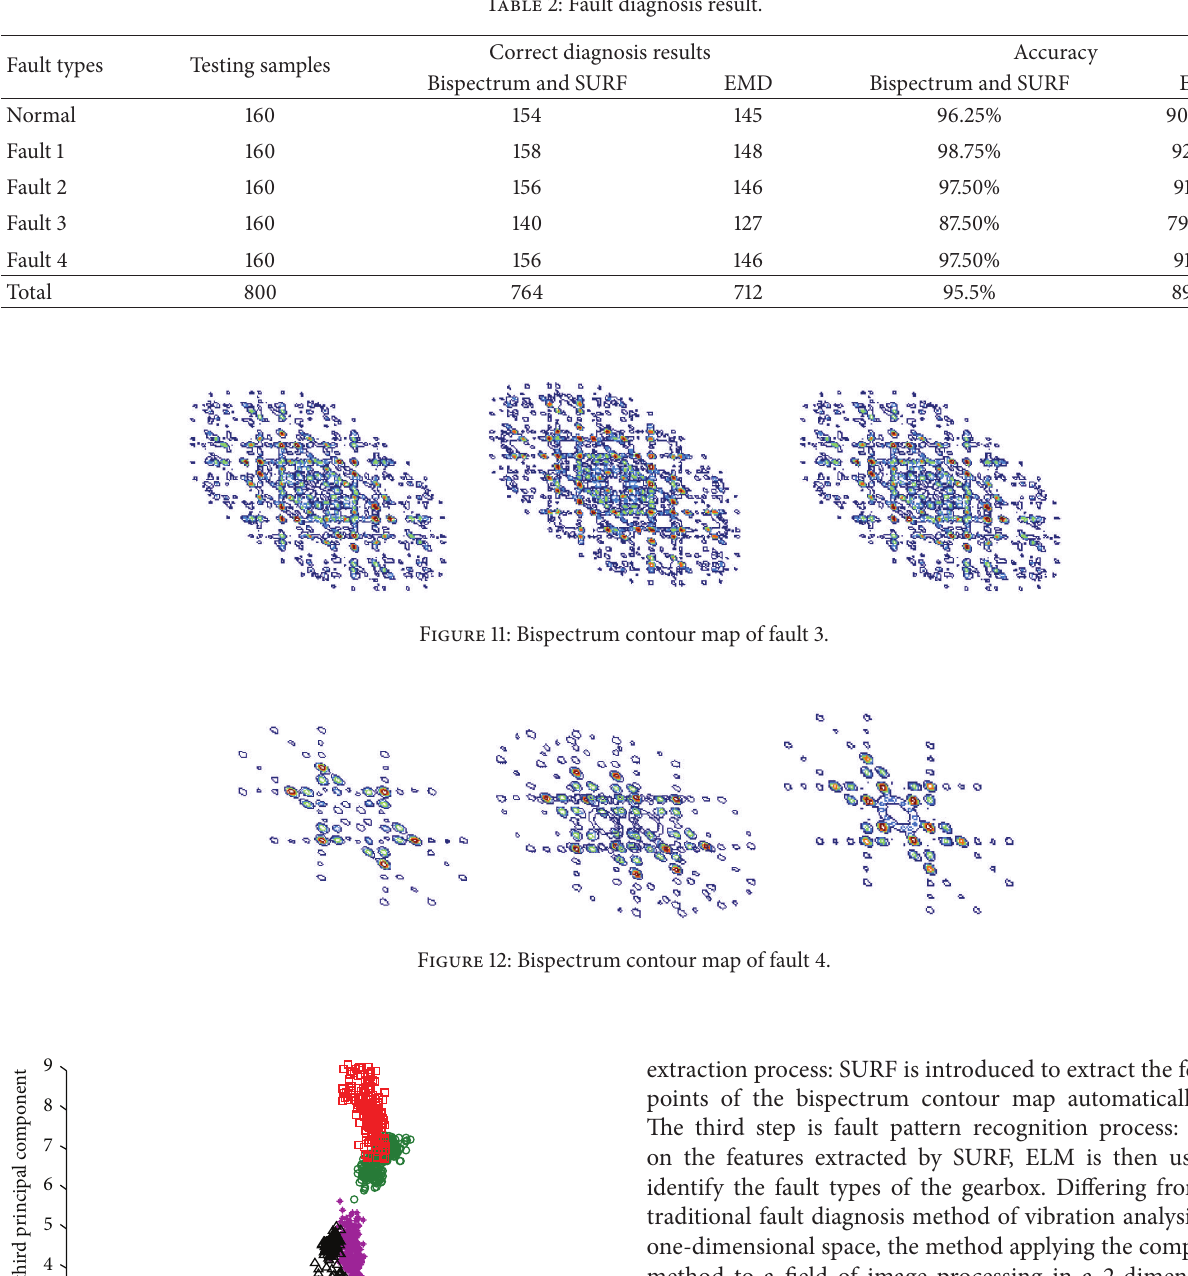
Table 2: Fault diagnosis result.